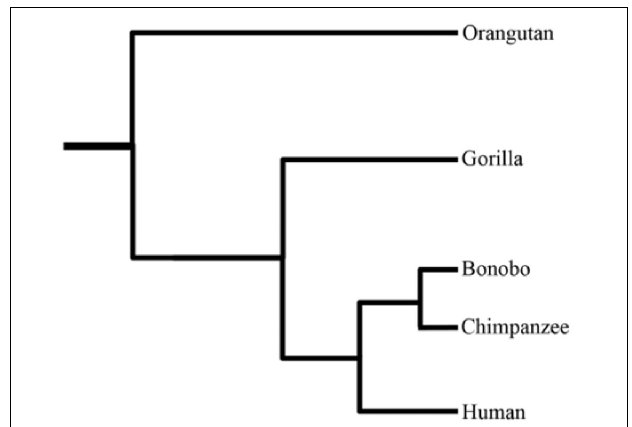
FIGURE 1 | The phylogenetic tree of great ape species (Prado-Martinez et al.,